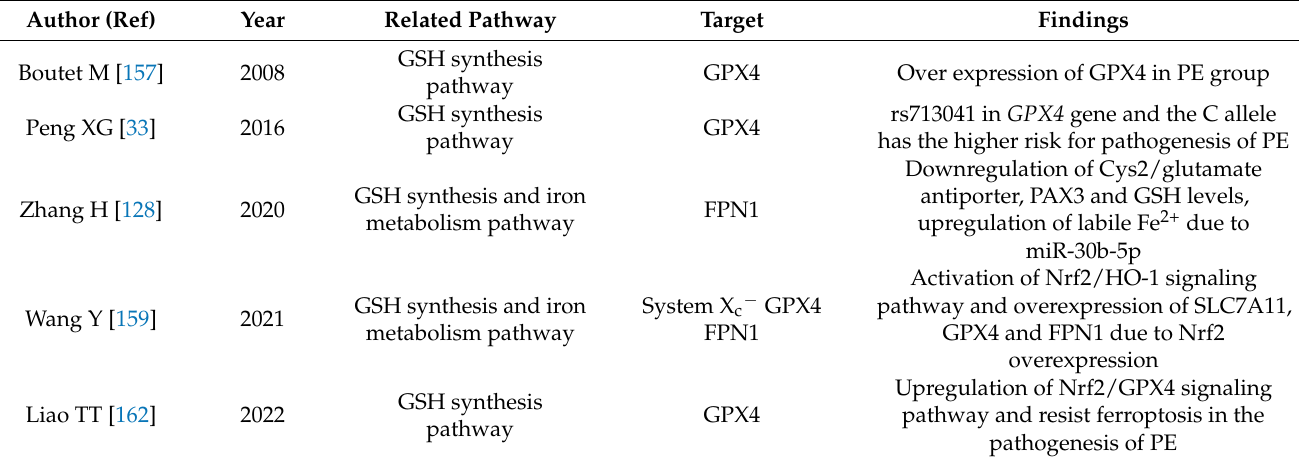
Table 1. Research progress on ferroptosis in